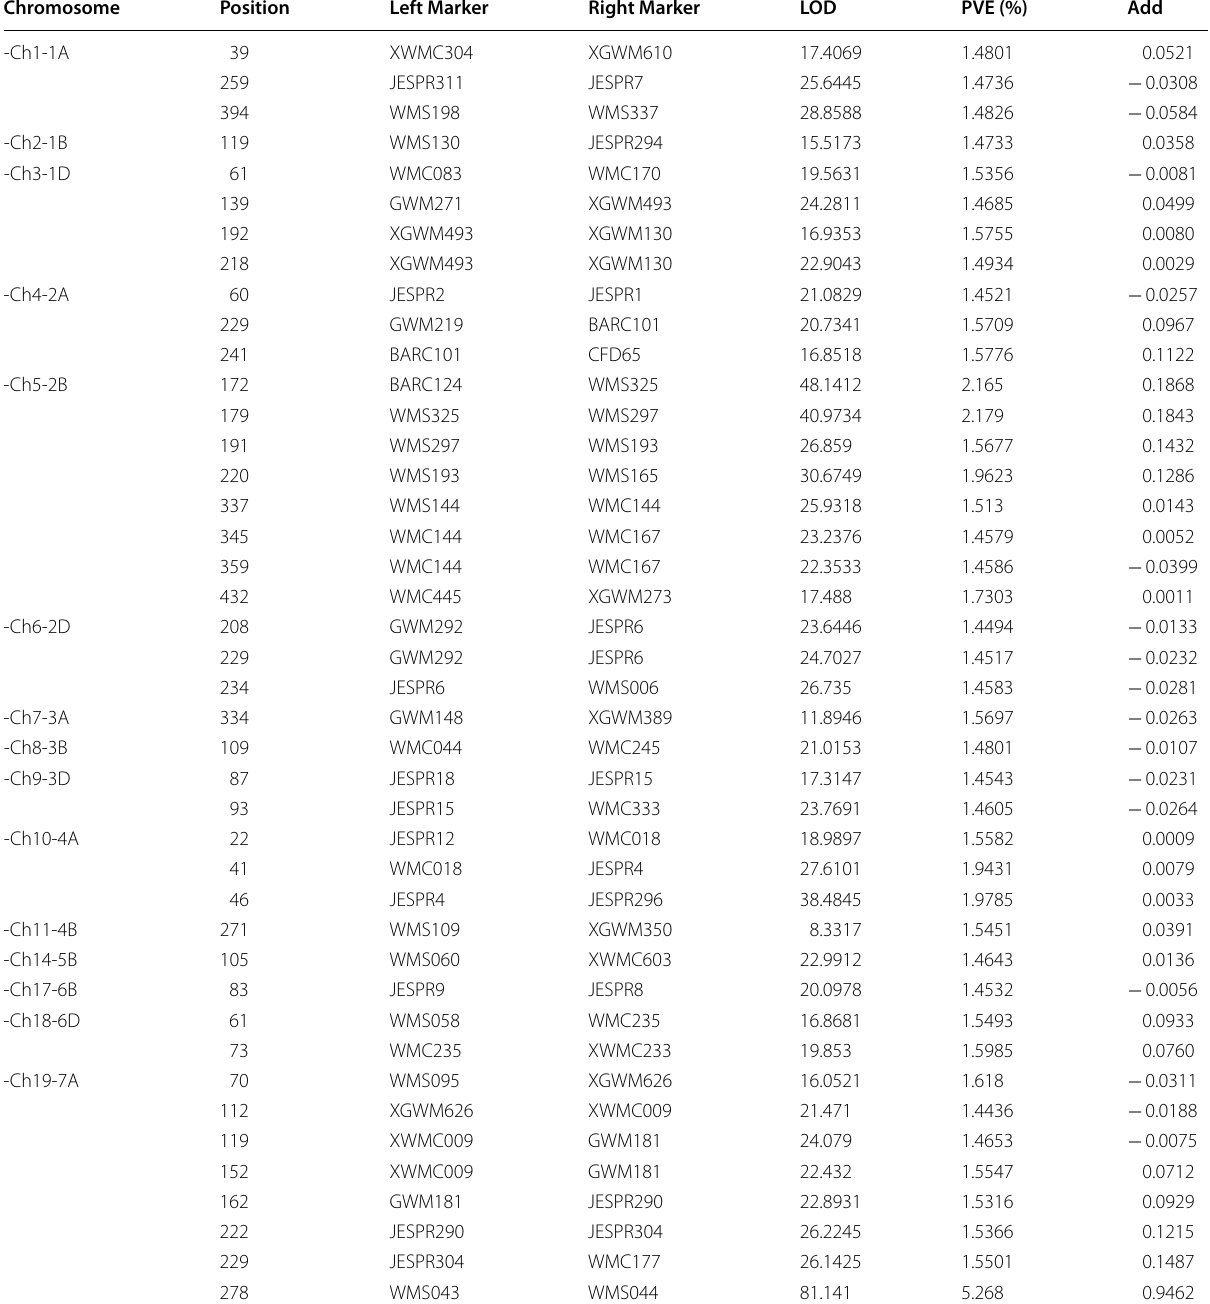
Table 6 Position, characters, and distribution the QTLs related to leaf wilting among nineteen chromosomes out of twenty‑one wheat